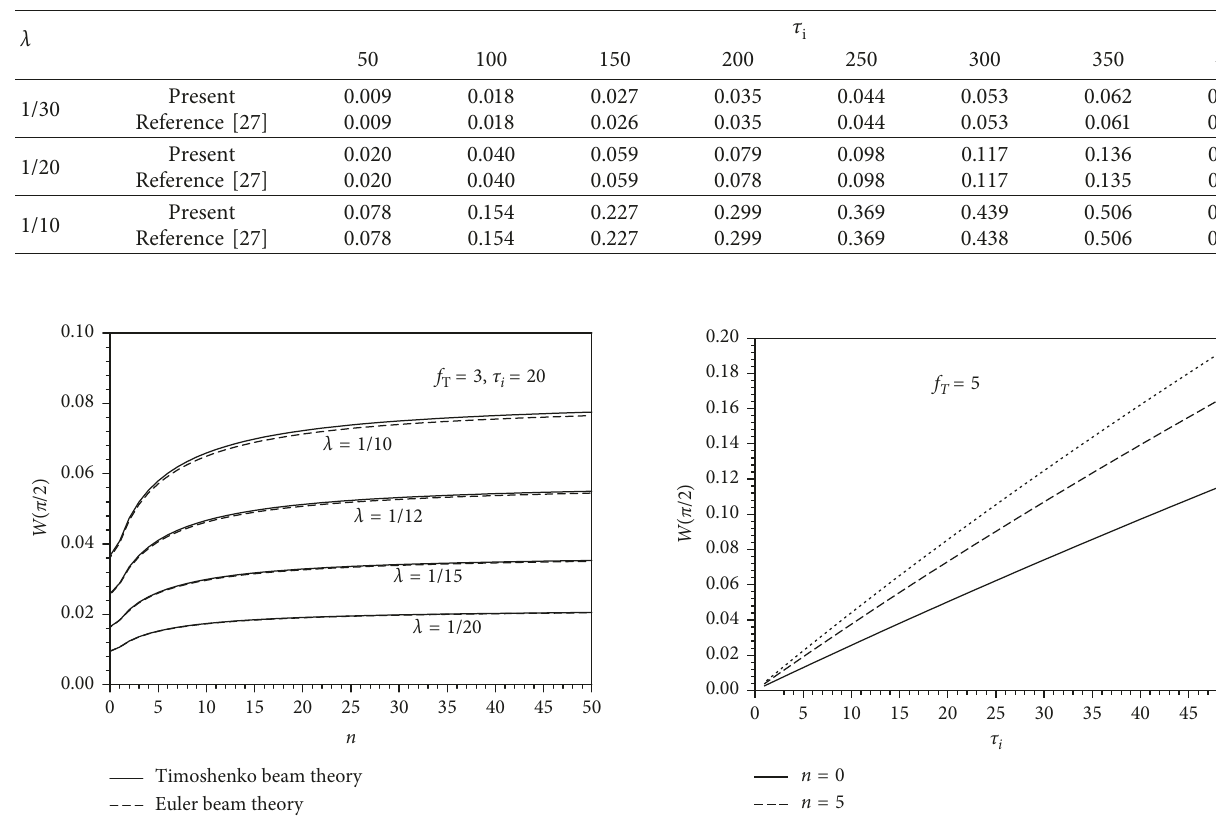
π /2 versus τ i with different values of n ( )